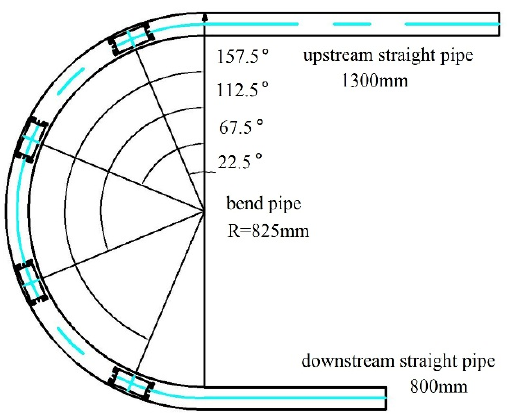
Figure 3. Schematic diagram of starting the wheeled capsule at different positions of the bend pipe. Table 2. Threshold of motion Reynolds numbers for different conditions.